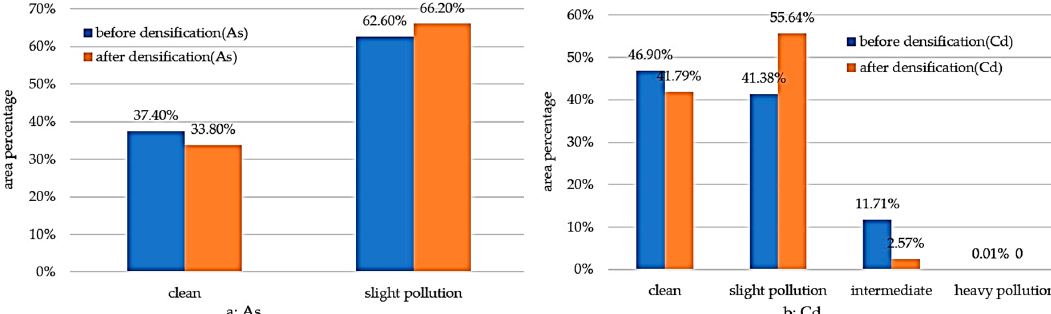
Figure 3. Statistics of each pollution level before and after densification. For As, the pollution grades were clean and slight pollution. For Cd, the pollution grades were clean, slight, intermediate, and heavy pollution. ( a ) The area percentage of each pollution level before and after densification of As, respectively; ( b ) the area percentage of each pollution level before and after densification of Cd, respectively.